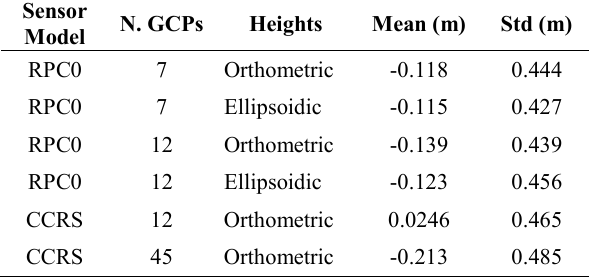
Statistic results on residuals elevations (LiDAR- GeoEye-1) for the DSMs with different combination of GCPs and different heights.